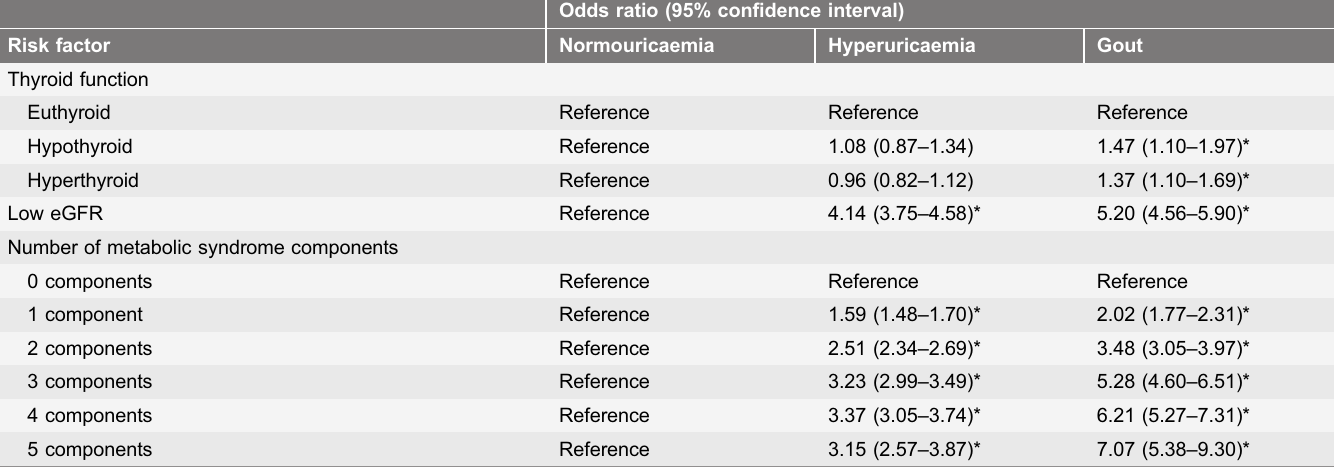
Table 2. Age- and multivariate-adjusted relative risks of hyperuricaemia and gout in men with euthyroid, hypothyroid, and hyperthyroid status. Odds ratio (95% confidence interval)